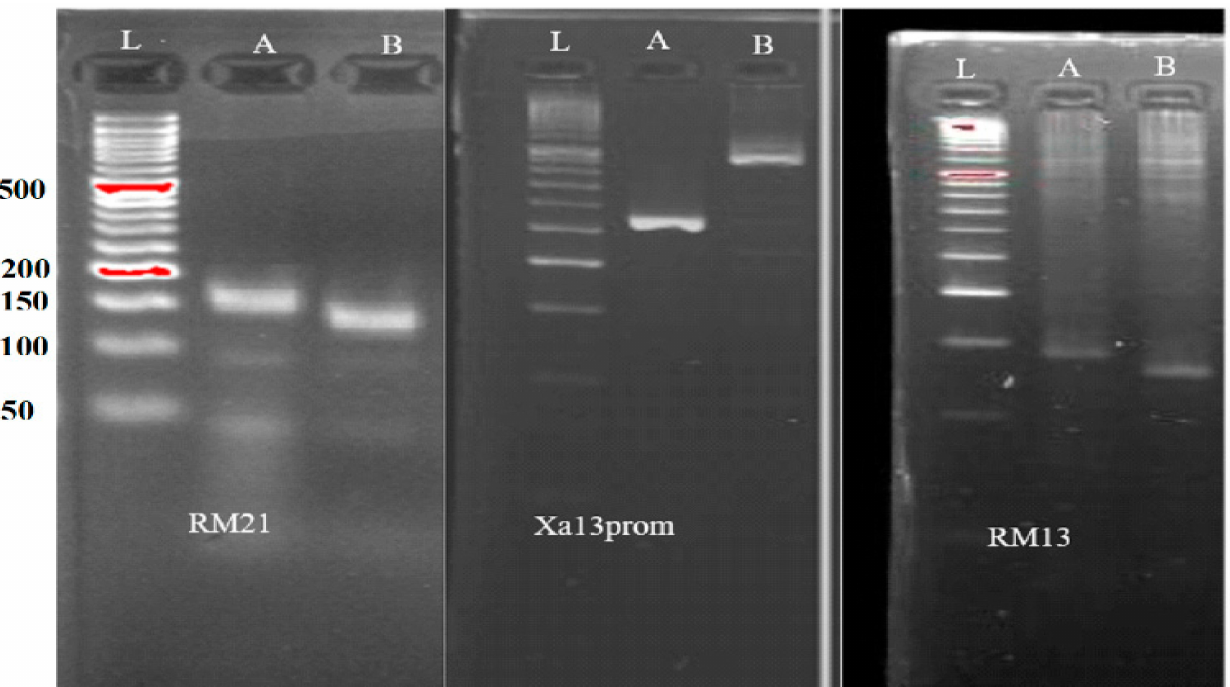
Figure 2. Molecular markers of foreground screening polymorphism amongst the two parents MR297 (A) and IRBB60 (B) for the various target genes: RM21 ( xa5 ), xa13-prom ( xa13 ), and RM13 ( xa5 ); L: 50 bp DNA